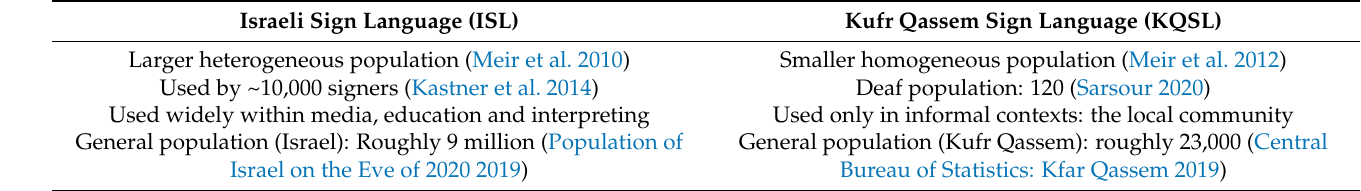
Table 3. Comparison of ISL and KQSL